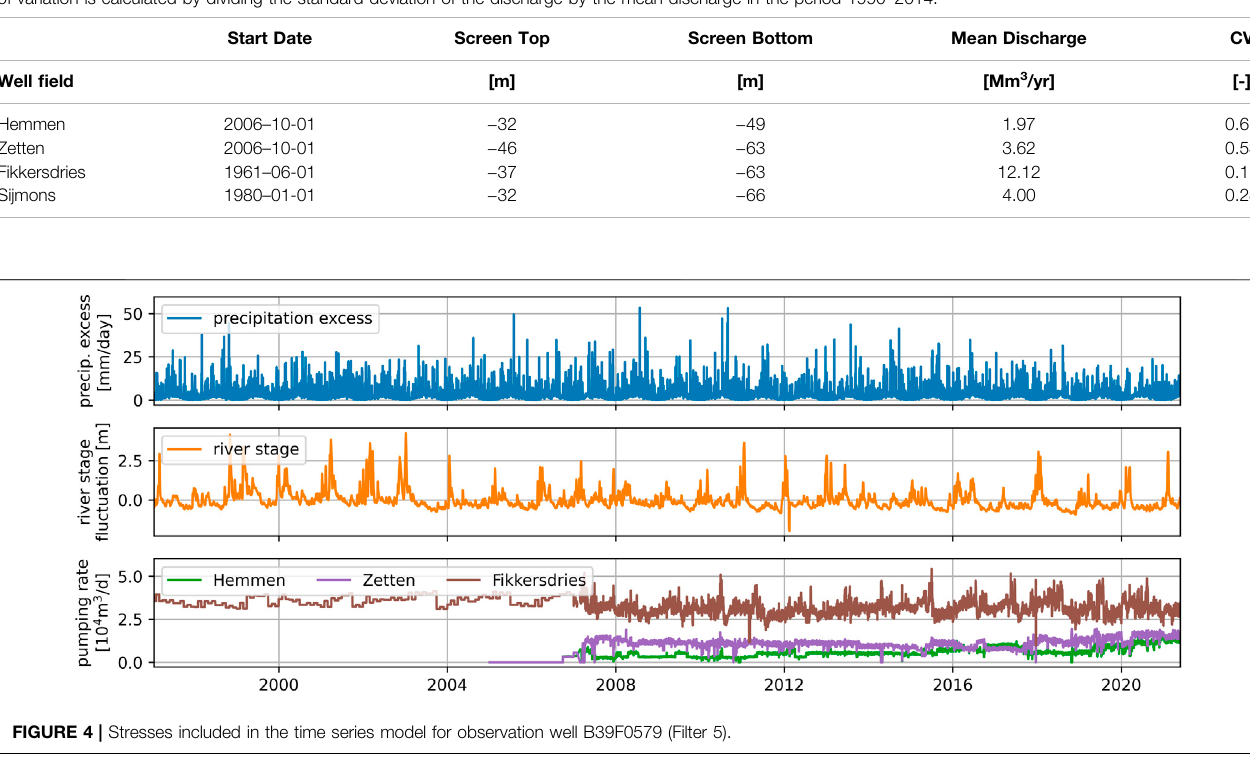
Frontiers in Earth Science |